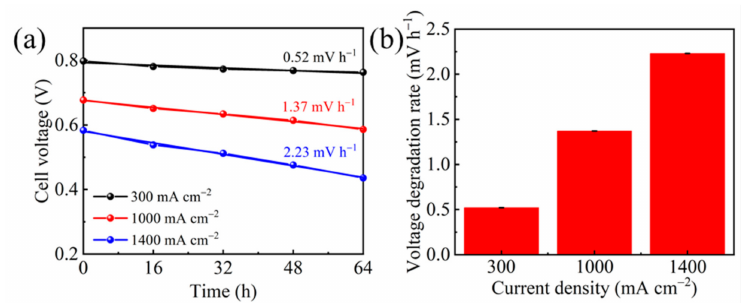
Figure 3. ( a ) Cell voltage versus operation duration and ( b ) the voltage degradation rate at different current densities.